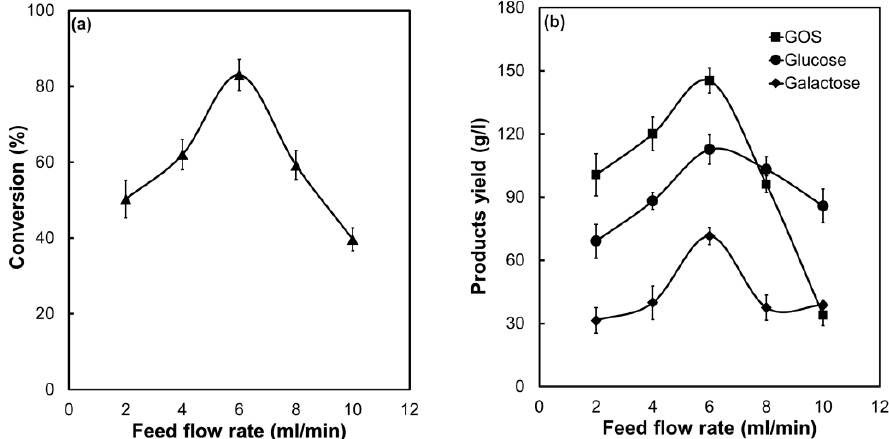
Figure 4. The effect of feed flow rate on ( a ) lactose conversion and ( b ) products yield from biocatalysis from immobilized β -galactosidase on PSNFs in a recirculating column reactor. Reactions were conducted at an initial lactose concentration of 400 g/L at 37 °C with an enzyme concentration of 2 mg/mL at pH 7 for 24 h reaction. Triplicate biological samples were prepared and data are shown as mean ± SD.